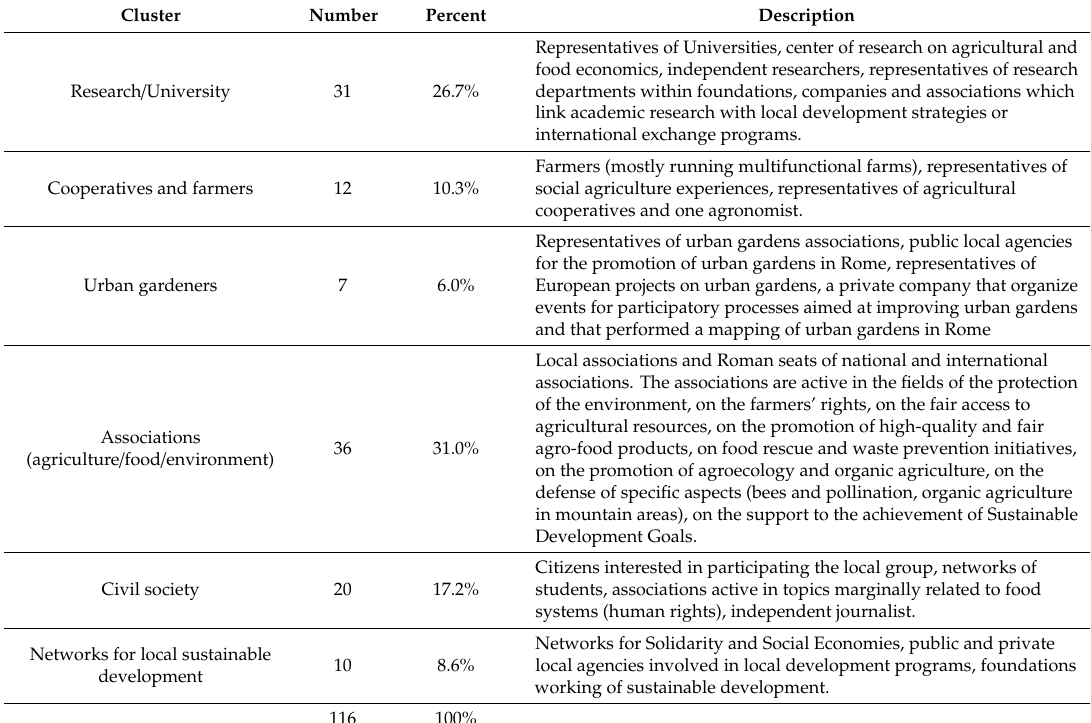
Table 1. Description of the clusters composing the local food policy group in Rome (Source: own